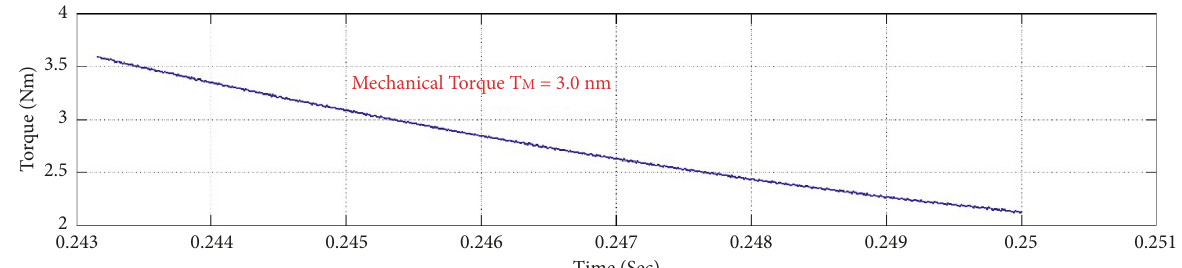
Figure 12: Mechanical torque